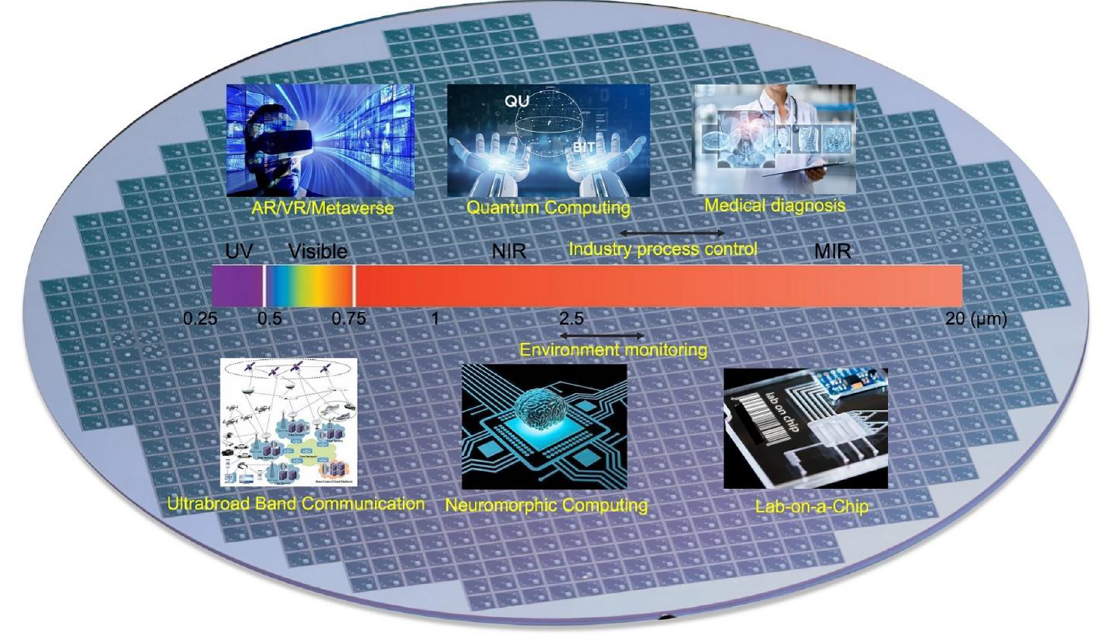
Figure 9: Future application outlook of wideband spectrum from visible to